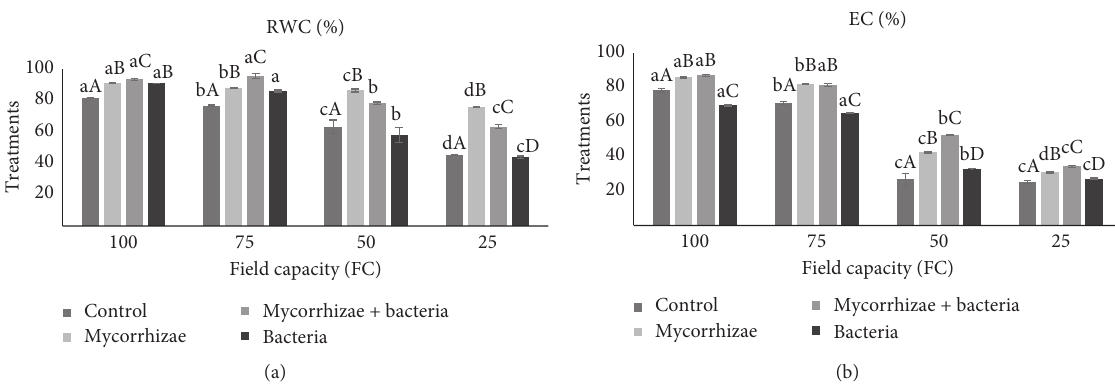
Figure 1: Effect of different water regimes on the water parameters ((a) RWC and (b) EC) of control, mycorrhizae, mycorrhizae +bacteria, and bacteria date palm seedlings after 8 months of growth. Lowercase letters in the same column indicate significant differences between FC at the same treatments ( p < 0 . 05). Uppercase letters in the same column indicate significant differences between treatments at the same FC ( p < 0 . 05).